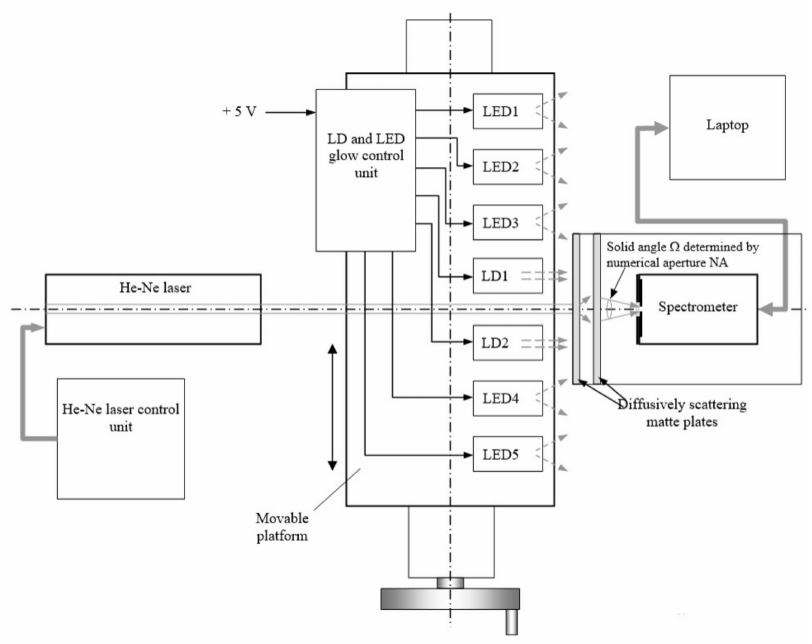
Figure 2. Functional diagram of the equipment for measuring spectra of the eight radiation sources